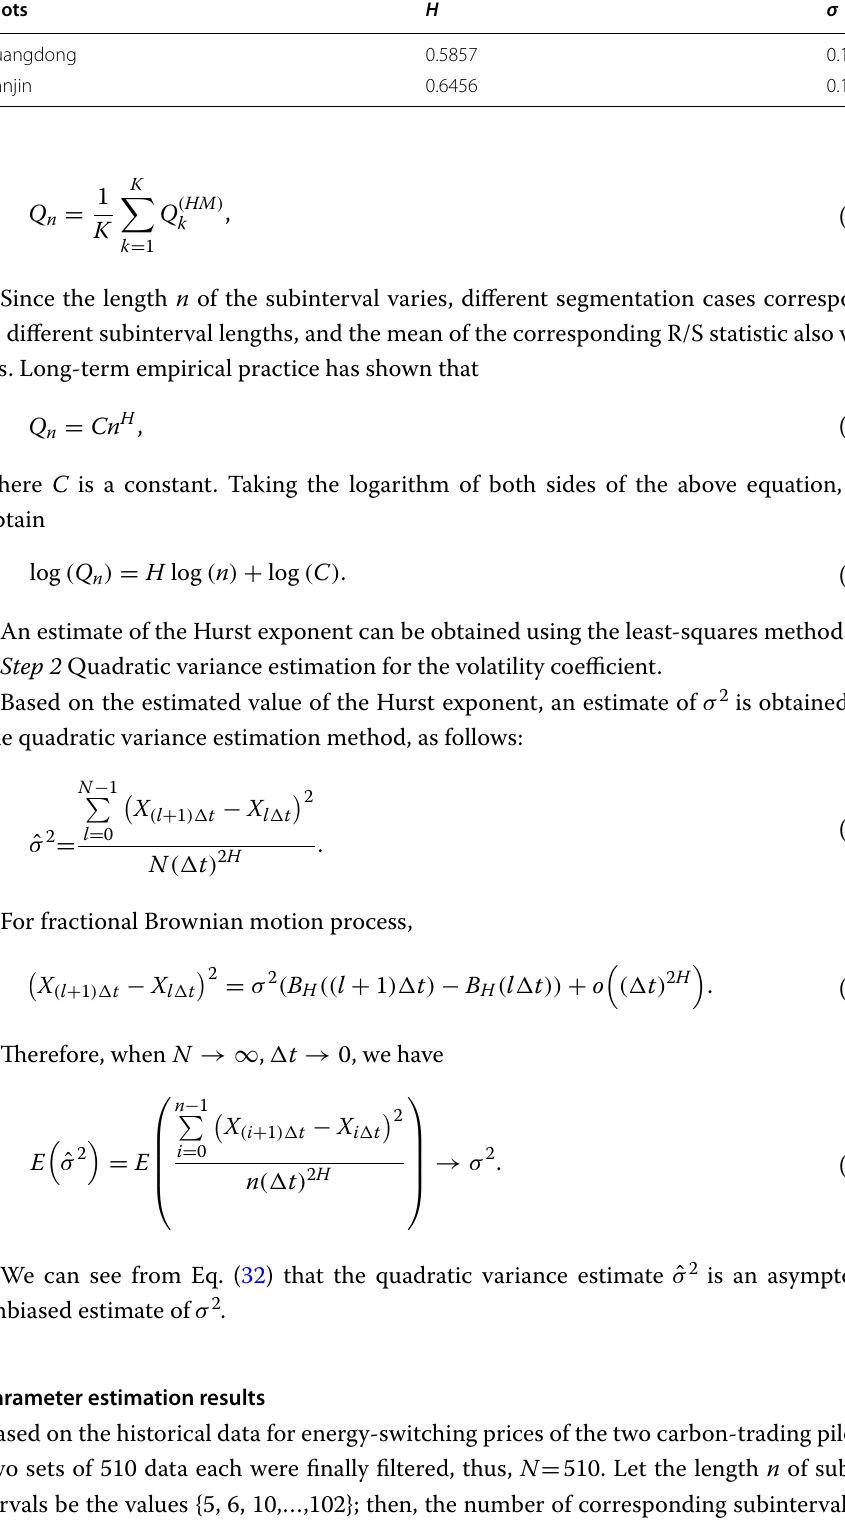
Table 3 Estimated parameter values Pilots H